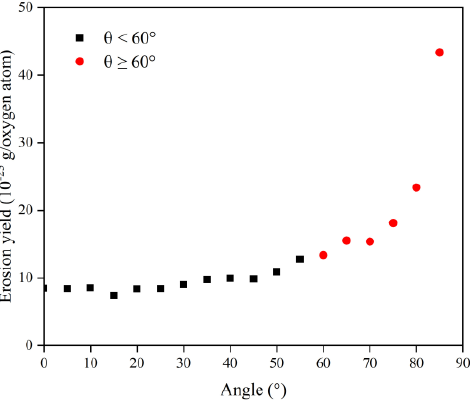
Figure 15. Erosion yield of the Kapton under atomic oxygen impact at different incidence angles.